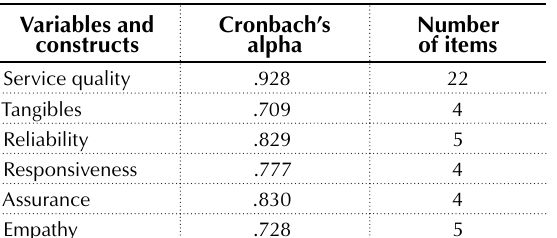
Table 1. Reliability scores of the